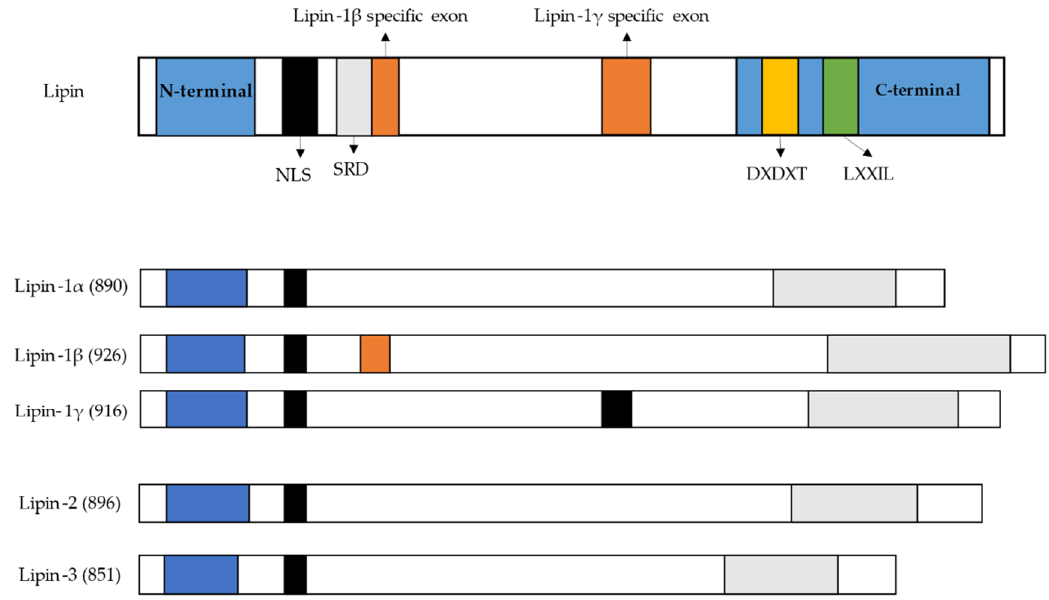
Figure 3. Lipin family (lipin-1, lipin-2, and lipin-3) domains and motifs in humans. N-terminal C-terminal NLS—nuclear localization; SRD—serine rich domain; DXDXT—phosphatidate phosphatase enzyme; LXXIL—transcriptional co-activator motif